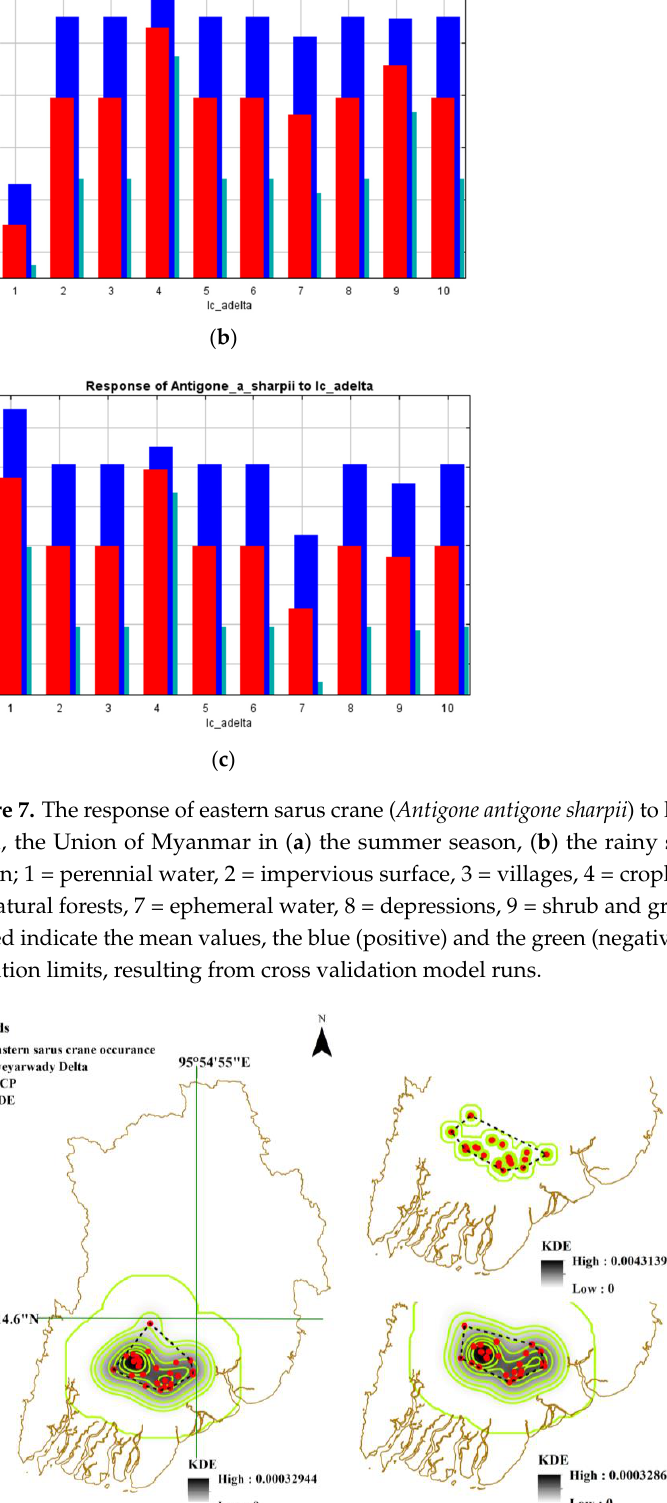
Figure 8. Estimating population home range and density of eastern sarus crane in Ayeyarwady Delta, the Union of Myanmar by using the Minimum Convex Polygon (95 % MCP) and the Kernel Density Estimate (95% KDE); ( a ) the summer season, ( b ) the rainy season, and ( c ) the winter season.